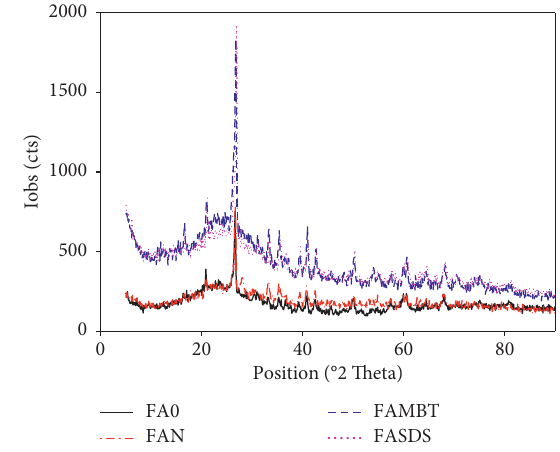
Figure 4: XRD patterns of FA0, FAN, and modified FAN